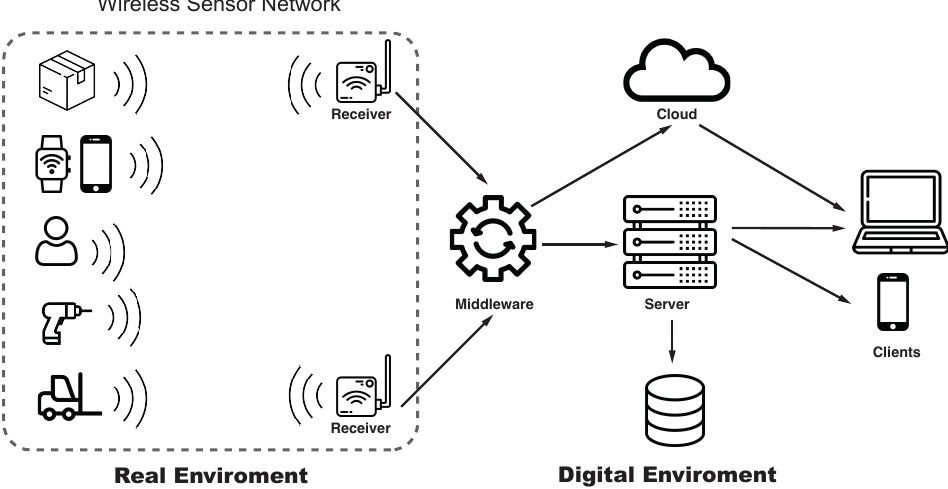
Figure 1. Exemplary illustration of an ATTS